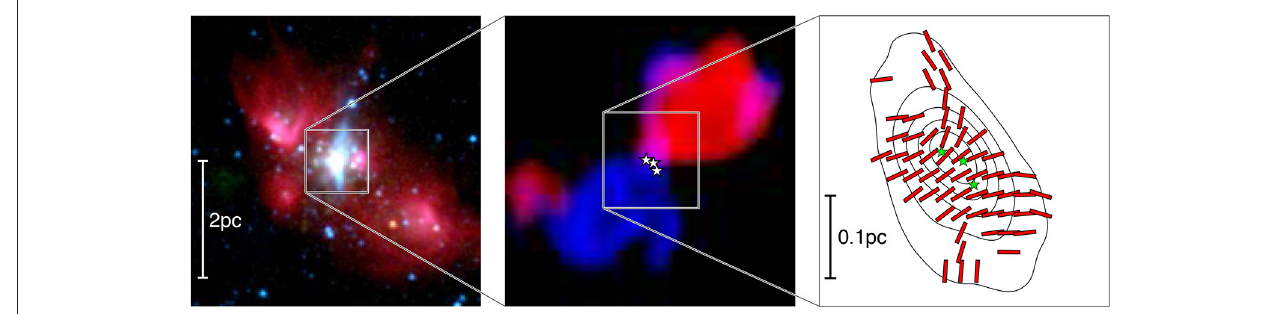
FIGURE 7 | Magnetic field (red line segments in the right panel) in the high-mass star formation region G240.31+0.07 inferred from dust continuum polarization at 870 µ m with the SMA (Qiu et al., 2014; Zhang et al., 2014). The left panel presents an overview of the region in a three-color composite of Spitzer IRAC images in the 3.6 µ m (green), 4.5 µ m (blue), and 8.0 µ m (red) bands; the middle panel shows a wide-angle bipolar molecular outflow in the CO( J star symbols indicate the known continuum peaks. Reproduced with permission from the